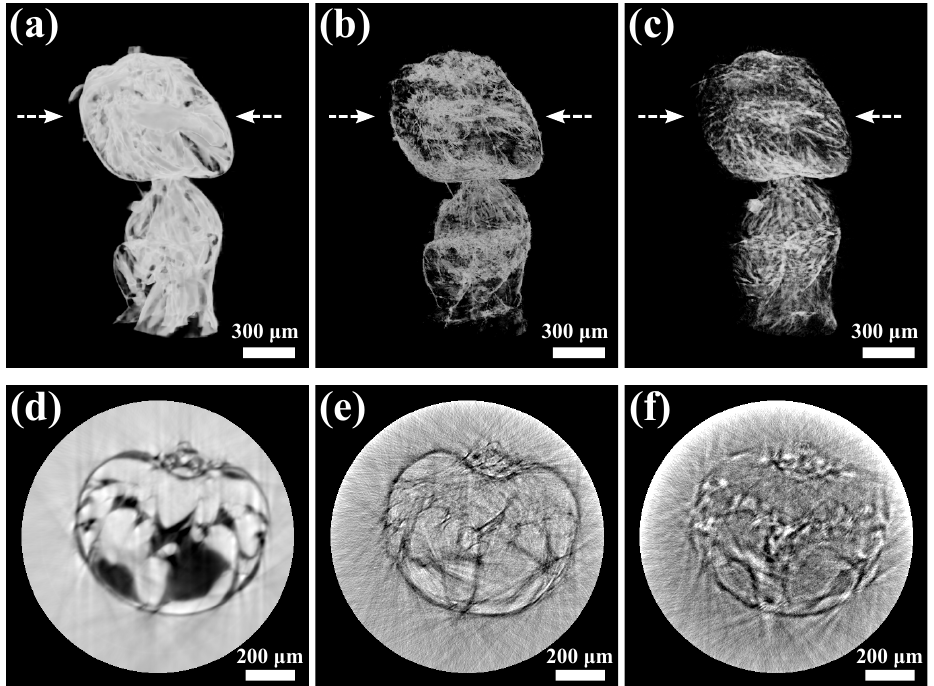
Figure 4. Tomography reconstruction results using scanning CMMI: volume rendering of ( a ) phase, ( b ) dark-field, and ( c ) transmission images of an ant sample. ( d – f ) are the reconstruction slices of ( a – c ) indicated by the arrow location,